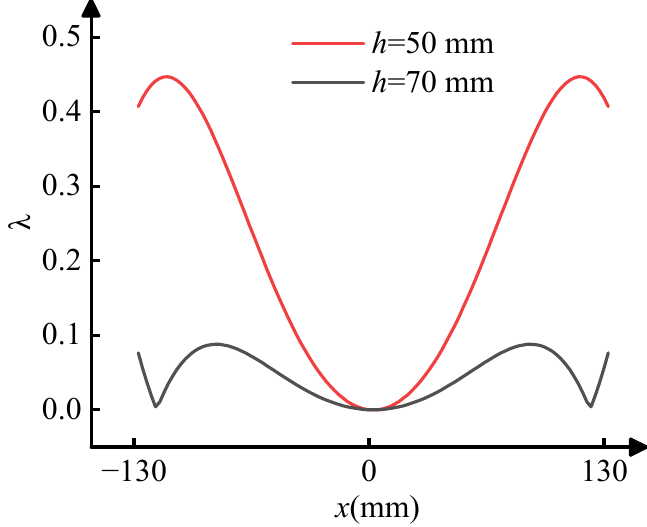
Figure 3. The discretization of B Z distribution on line l 1 .